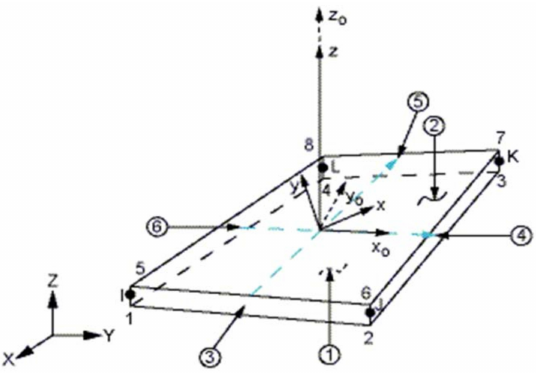
Figure 5. Schematic diagram of element SHELL181 [28].